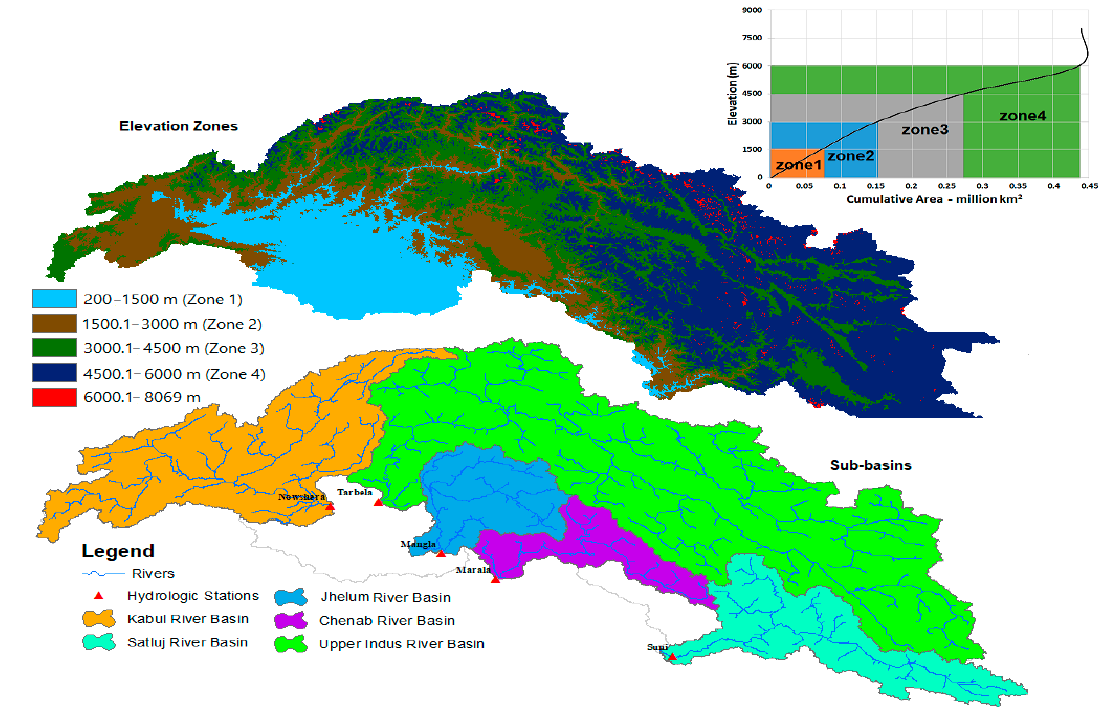
Figure 2. Elevation zones and main sub-basins of the study area.